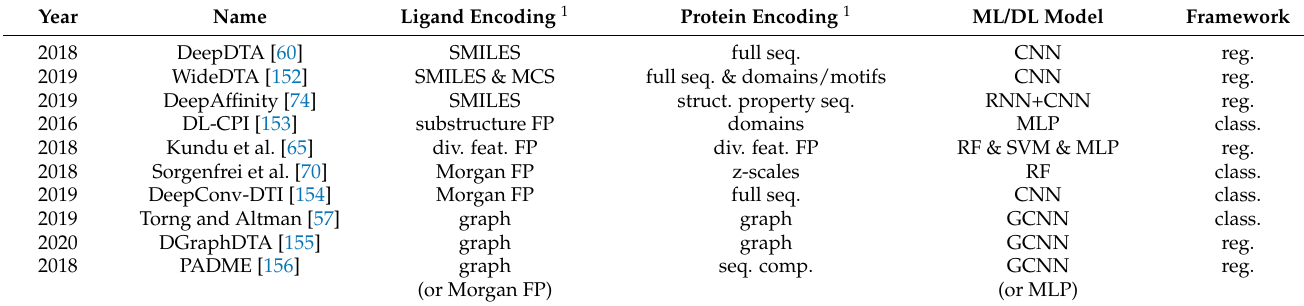
Table 4. Pair-based models. The listed models consider information from the protein and the ligand, but the encodings are built independently of each other. The year of publication, the name of the authors or the model, the ligand and the protein encodings and the machine/deep learning model(s) are shown in the respective columns. Classification (class.) implies hit or non-hit, whereas regression (reg.) evaluates an affinity measure, for example pIC 50 values. Graphs and associated GCNNs have become prominent in recent